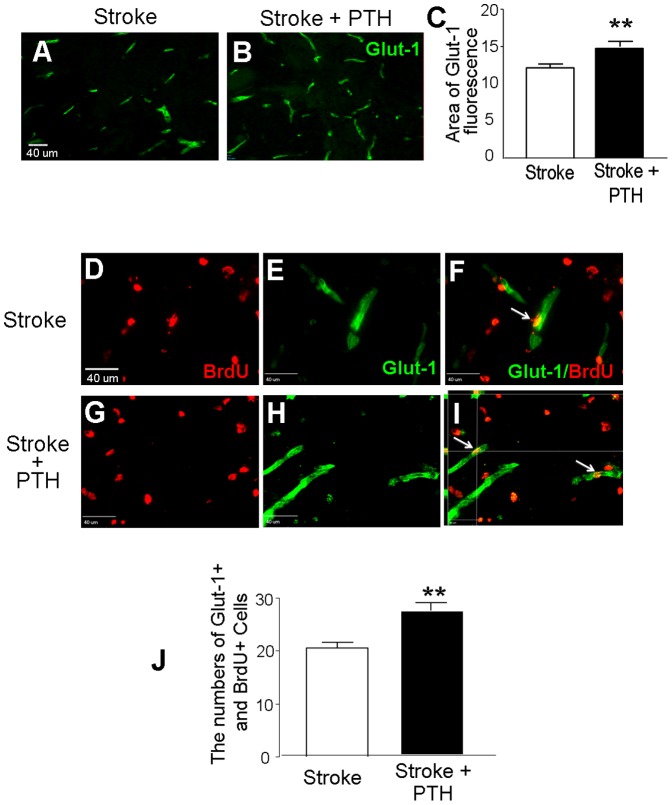
PTH enhanced angiogenesis at the peri-infarct region 14 days after stroke.Fourteen days after stroke, endothelial cells and cell proliferation at the peri-infarct region was inspected using immunohistochemical methods. A and B. Representative Glut-1 (green) staining of vascular endothelial cells in the brain section from stroke/saline and stroke/PTH mice. C. The area of Glut-1 fluorescent reactivity in stroke/saline and stroke/PTH groups. D to I. Fluorescent labeling of Glut-1+ (green) and BrdU+ (red) cells. F and I are 3-D images showing co-localized labeling of Glut-1 and BrdU, indicative of angiogenesis. J. Quantified data of fluorescent reactivity of Glut-1/BrdU double positive cells; PTH treatment significantly promoted angiogenesis. N = 6; ** P<0.01 vs. stroke control.